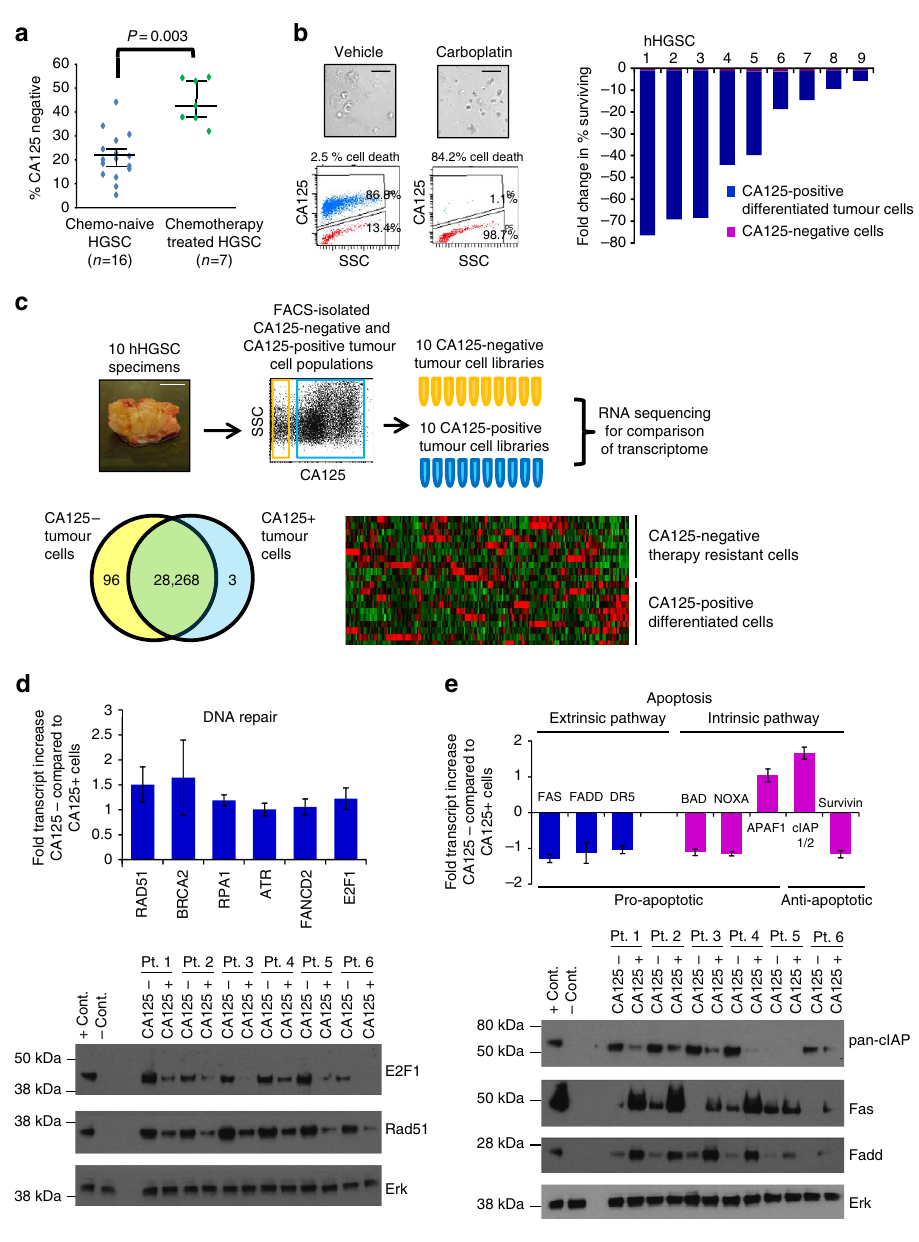
NATURE COMMUNICATIONS|7:10703|DOI: